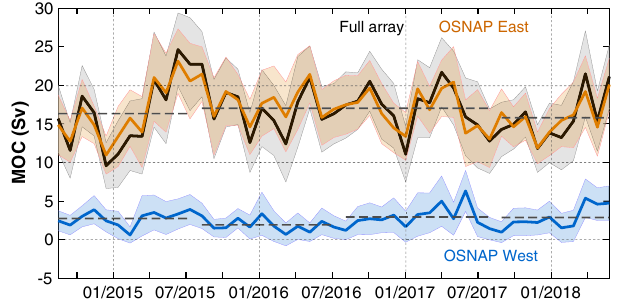
Fig. 2 Subpolar Meridional Overturning Circulation (MOC) time series. 30-day MOC estimates across the full array, OSNAP West and East, respectively. Shading indicates uncertainty in the 30-day estimate, obtained from a Monte Carlo method 10 . Horizontal dashed lines indicate the 12- month averages (10-month for 2017 – 2018). The total Ekman transport (not shown) is (cid:2) 1 : 5 ± 0 : 02Sv during the whole